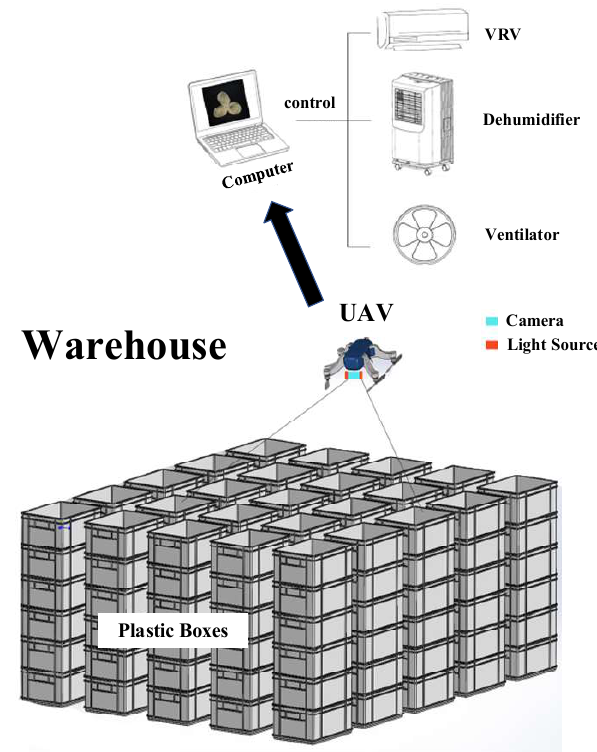
Figure 2. UAV inspection program diagram.